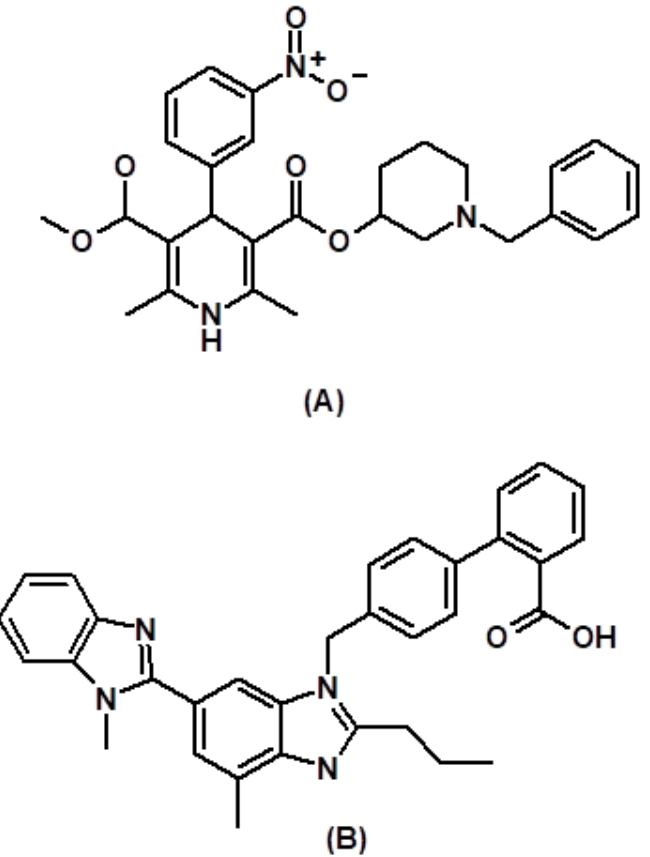
Figure 1. Chemical structure of benidipine ( A ) and telmisartan ( B ).